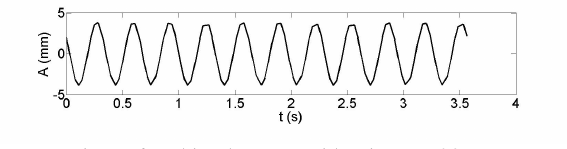
Figure 6c. Thin plate centroid trajectory-30 Hz